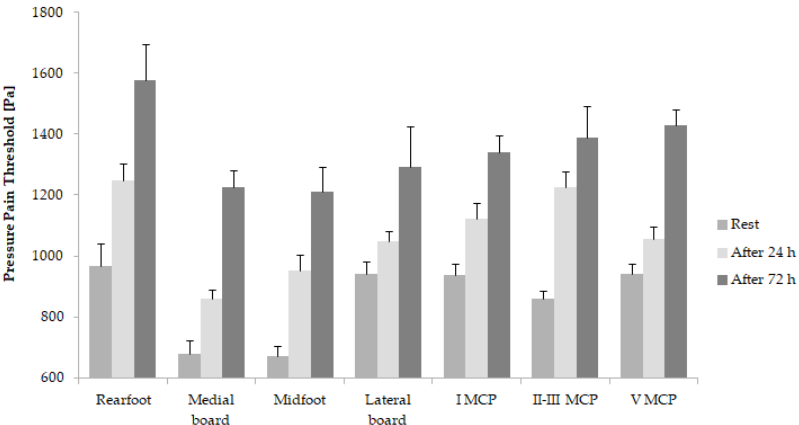
Figure 3. Plantar pressure pain threshold during 72 h period of plantar fascial taping in futsal